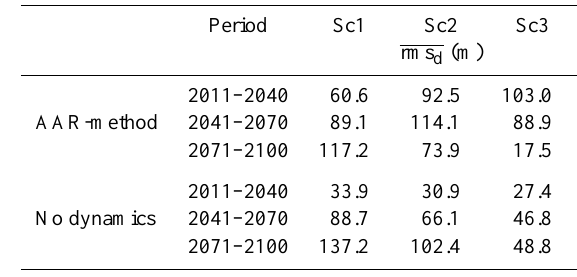
Table 3. Comparison of surface elevation calculated using supple- mentary simple parameterizations to calculate glacier retreat with the ice flow model for three 30-year periods and scenarios in the future (Rhonegletscher). The root-mean-square errors rms d of the difference in elevation at all grid cells averaged over the period con- sidered.